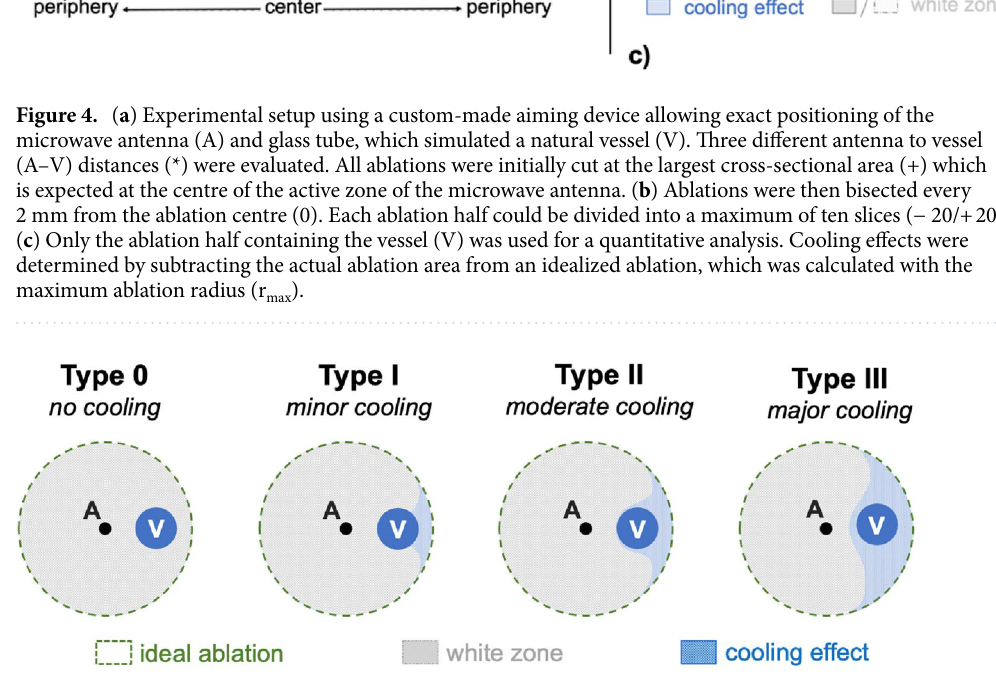
Figure 5. The effect of vascular cooling on ablation shape was assessed using a semiquantitative classification scheme: Type 0: no cooling, Type I: minor cooling, Type II: moderate cooling, Type III: major